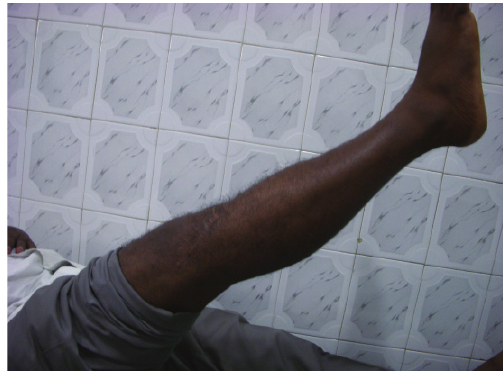
Figure 9: Clinical picture at 2-year followup after figure of 8 wire removal showing active SLR.